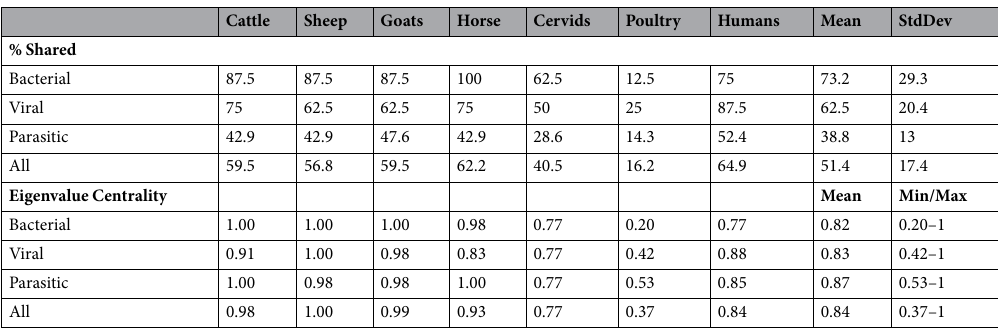
Table 4. Swine pathogens that cause clinical disease in livestock, poultry, cervids and